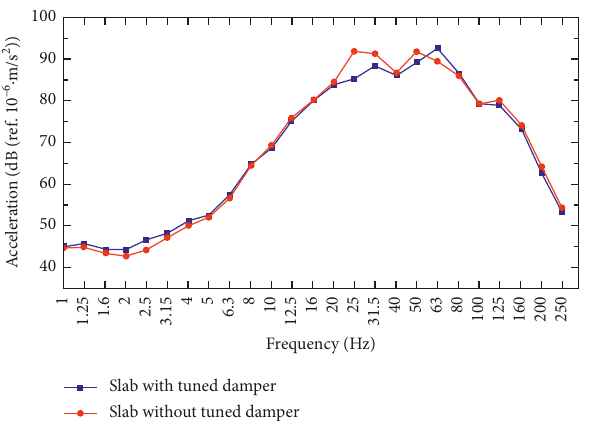
Figure 16: 1/3 frequency path spectrum of the track plate (hammered at fastener).